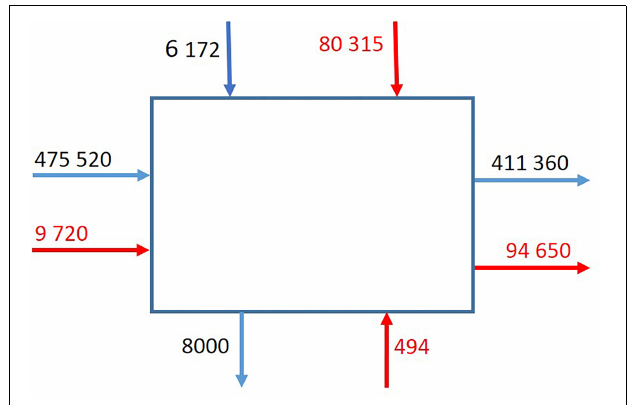
FIGURE 6 | The average annual flux (t C) of C. finmarchicus (red) and C. glacialis (black) into the box from the west, north and south, and out toward to the